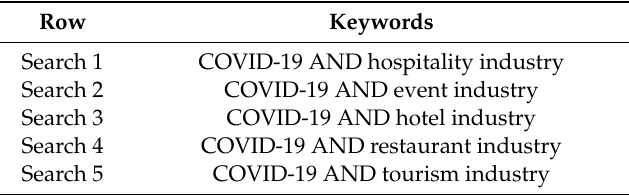
Table 1. Keywords used in the literature search.